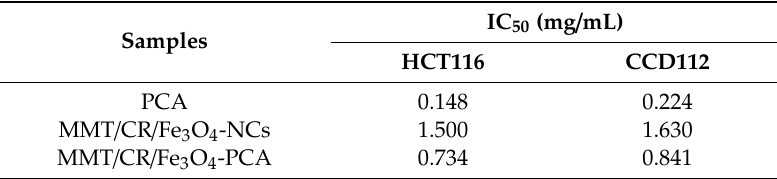
Table 1. IC 50 value of samples on HCT116 and CCD112.